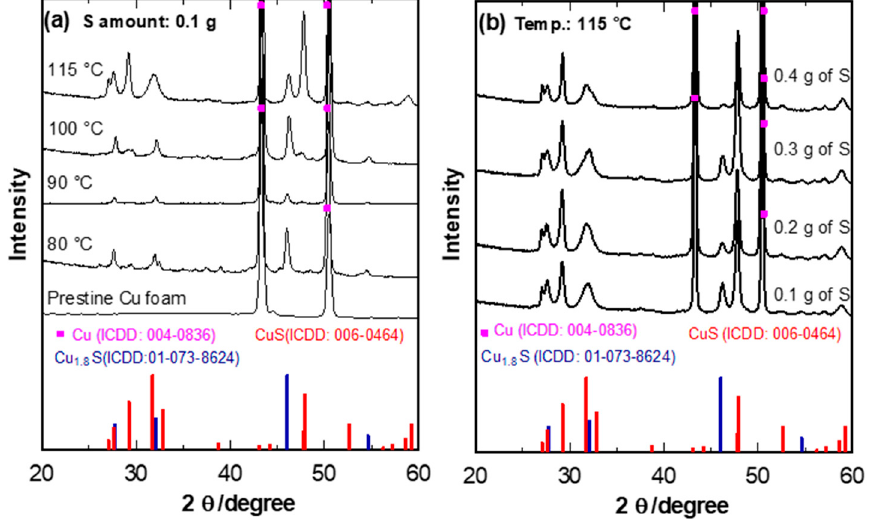
Figure 1. XRD patterns of Cu x S on Cu foam ( a ) at different synthesis temperatures with S amount of 0.1 g dissolved in DMSO; and ( b ) samples at 115 °C for 3 min with different amounts of S dissolved in DMSO.